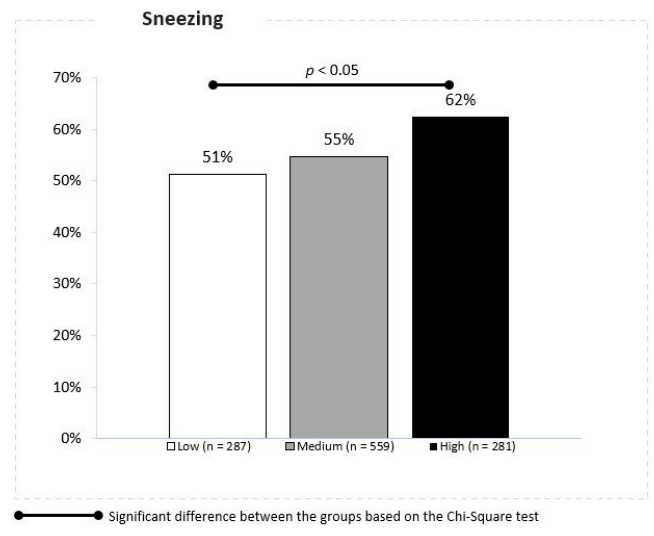
Figure 6. Association between the PM 2.5 concentrations and cough.